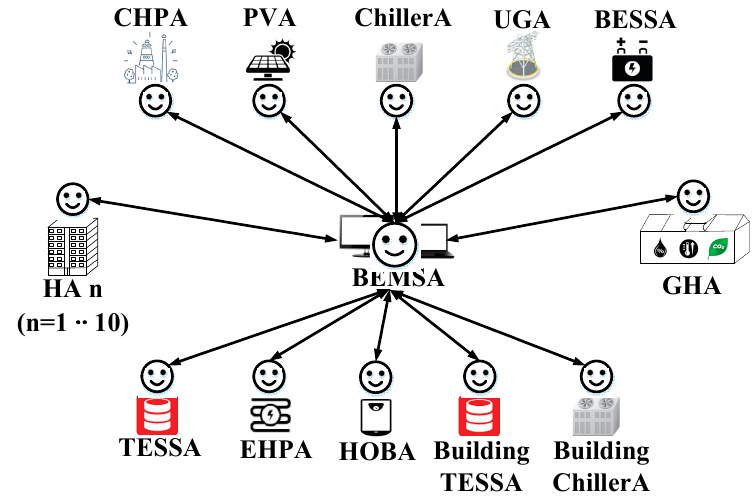
Figure 3. Multi-agent configuration of building energy management system (BEMS).